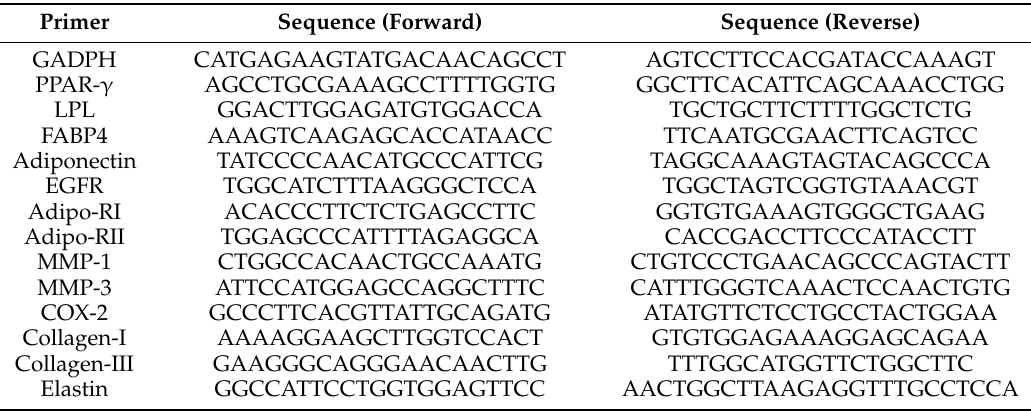
Table 1. Primer sequences used in the real-time PCR experiment.